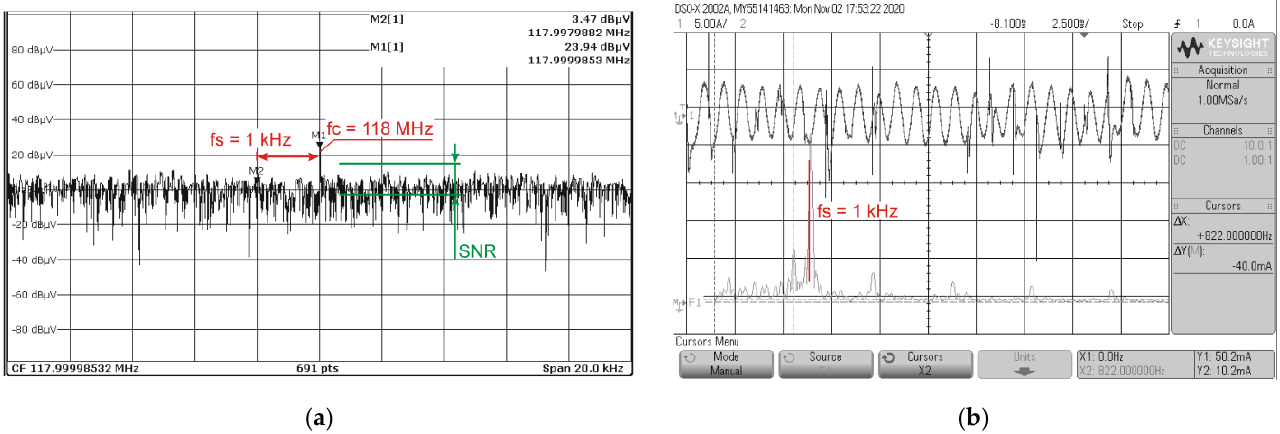
Figure 7. VHF receiver circuits in the disturbing environment, signal in the RF spectrum ( a ) and LF output signal, in time domain and its spectrum ( b ) .